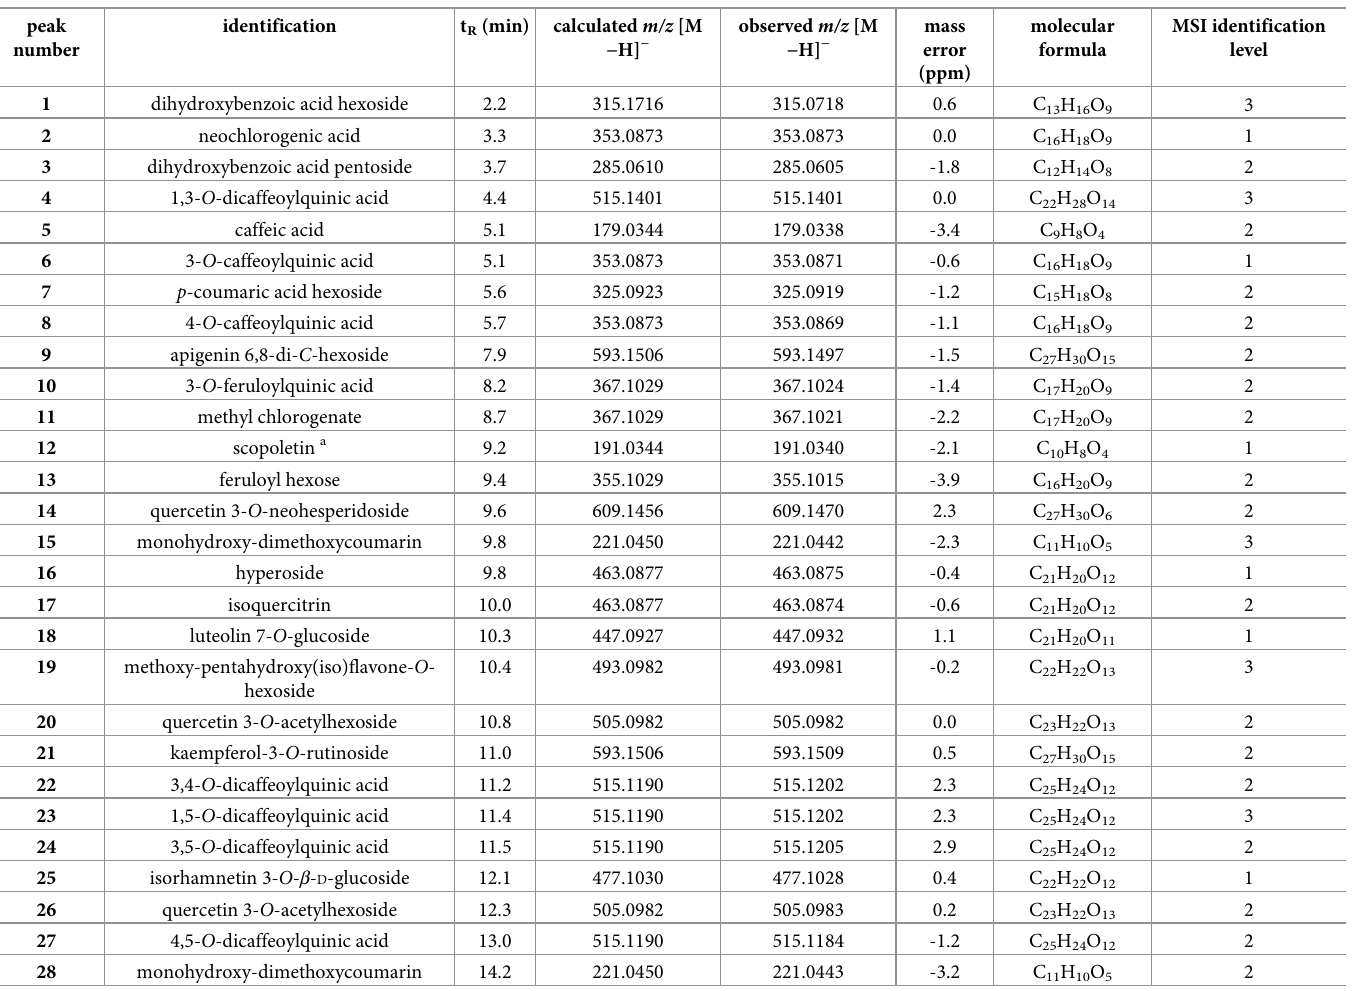
Table 3. Chromatographic and spectrometric data of the 28 tentatively identified metabolites from Artemisia